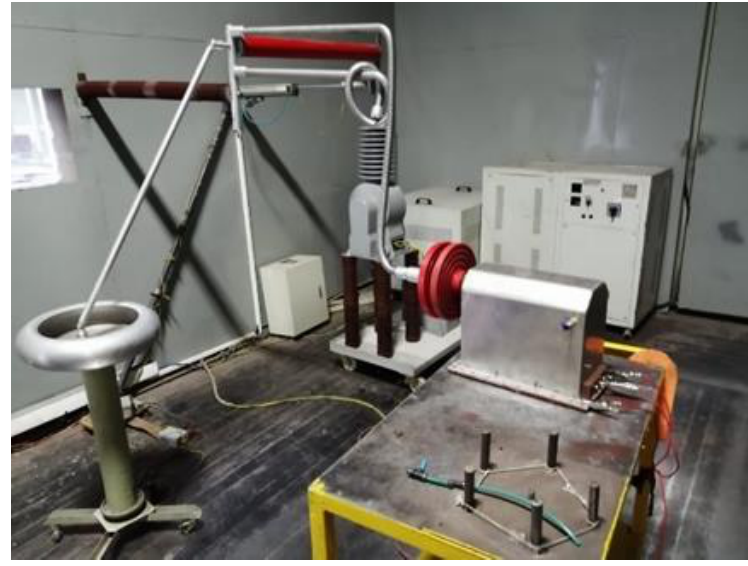
Figure 6. Laboratory experimental setup for partial discharge test.